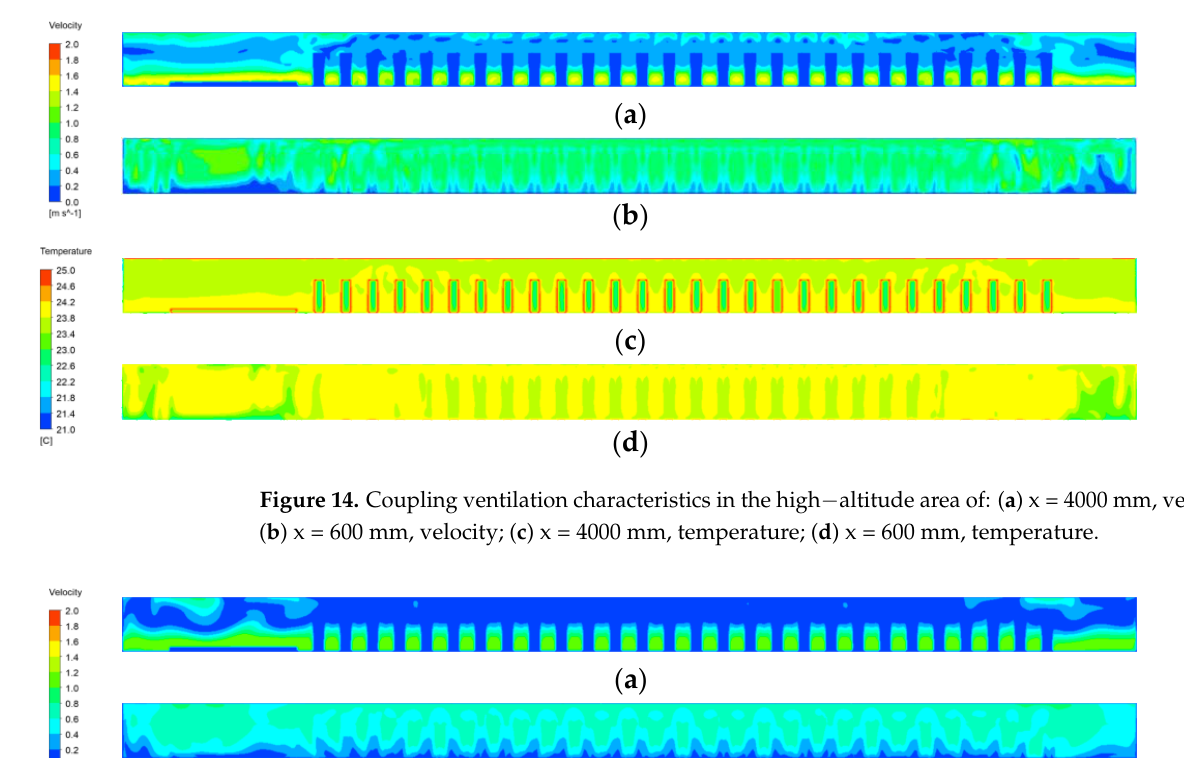
Figure 14. Coupling ventilation characteristics in the high − altitude area of: ( a ) x = 4000 mm, velocity; ( b ) x = 600 mm, velocity; ( c ) x = 4000 mm, temperature; ( d ) x = 600 mm, temperature.